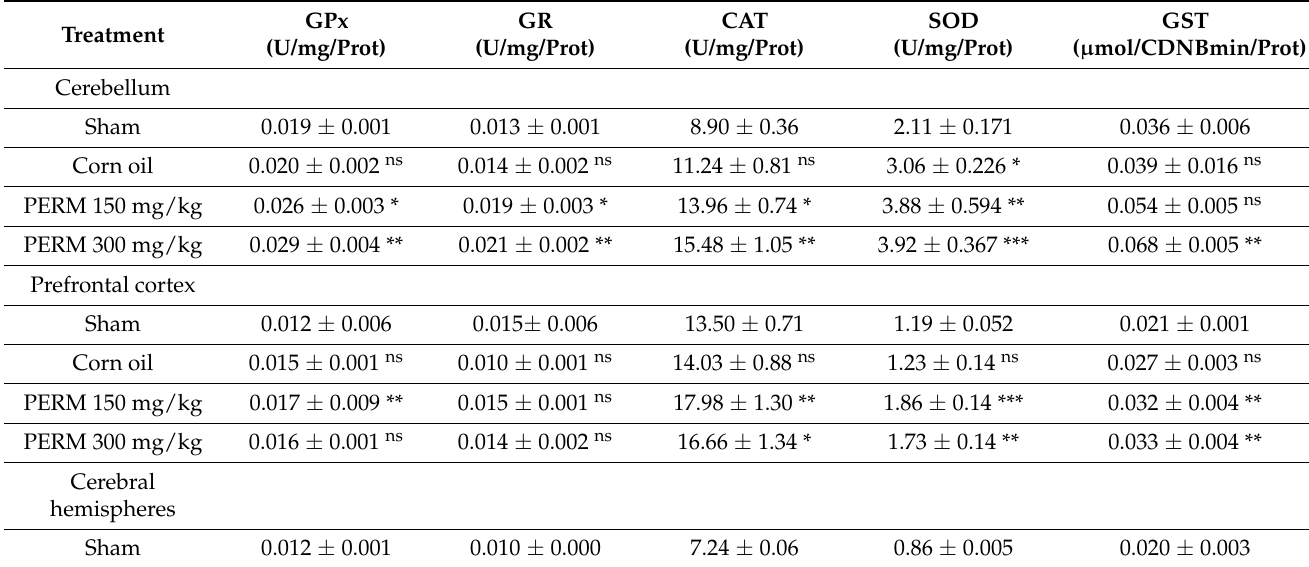
Table 3. Effect of permethrin (150 and 300 mg/kg body weight/day) on the activity of antioxidant enzymes in different brain